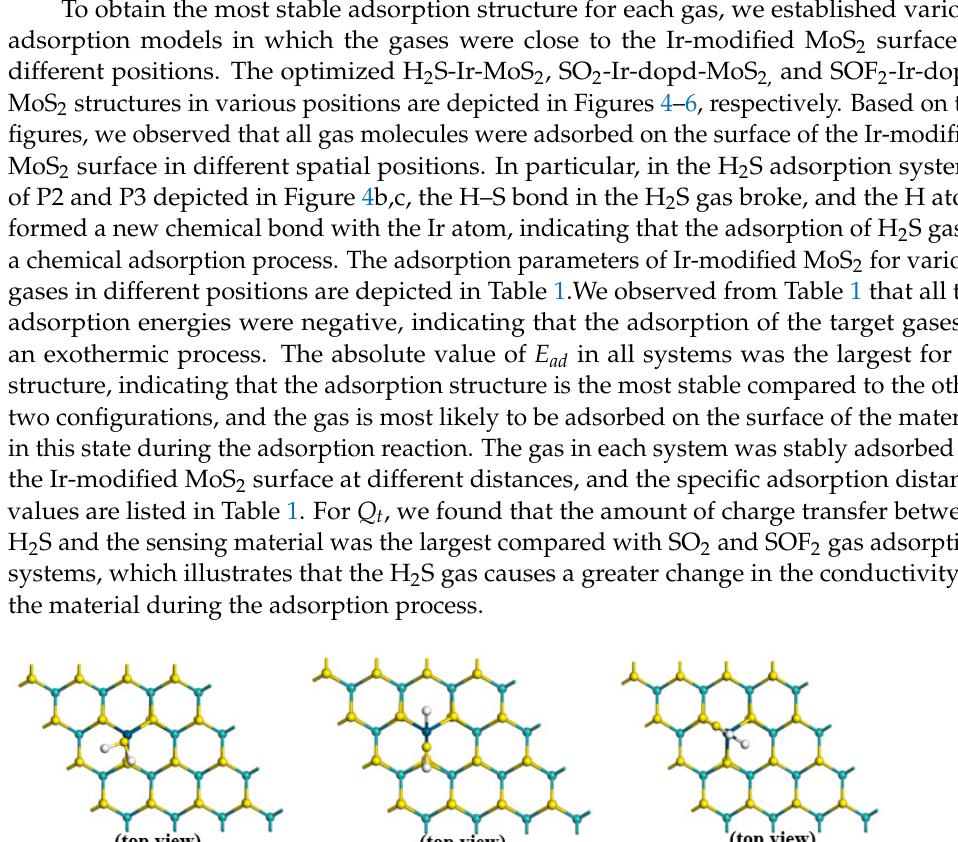
Figure 5. Different optimized structures of SO 2 adsorption on the Ir-modified MoS 2 surface.